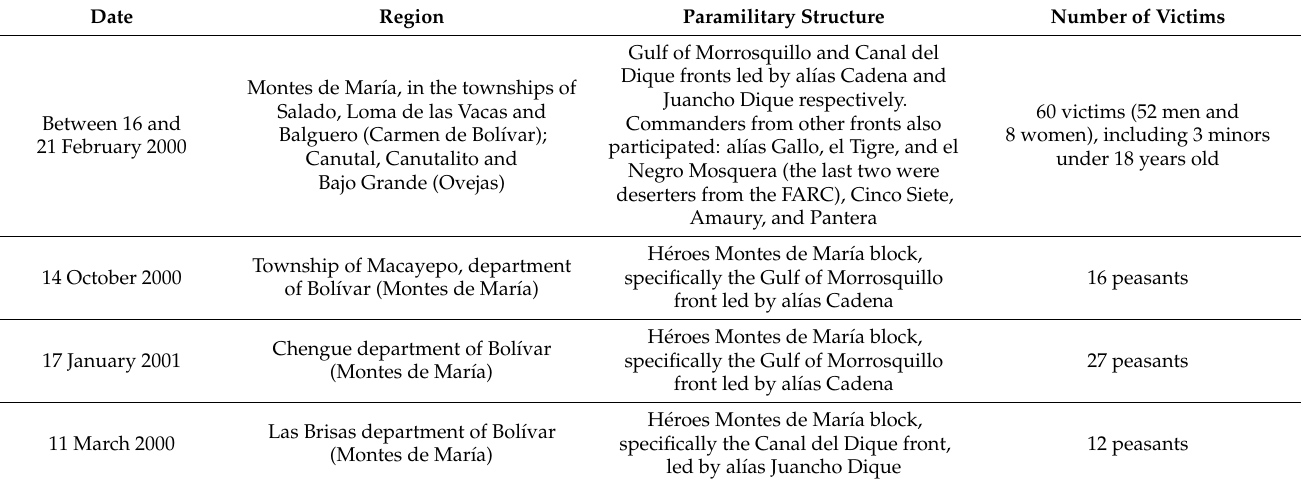
Table 3. Description of some of the massacres perpetrated by the paramilitaries in the Montes de Mar í a. Paramilitary Structure Number of